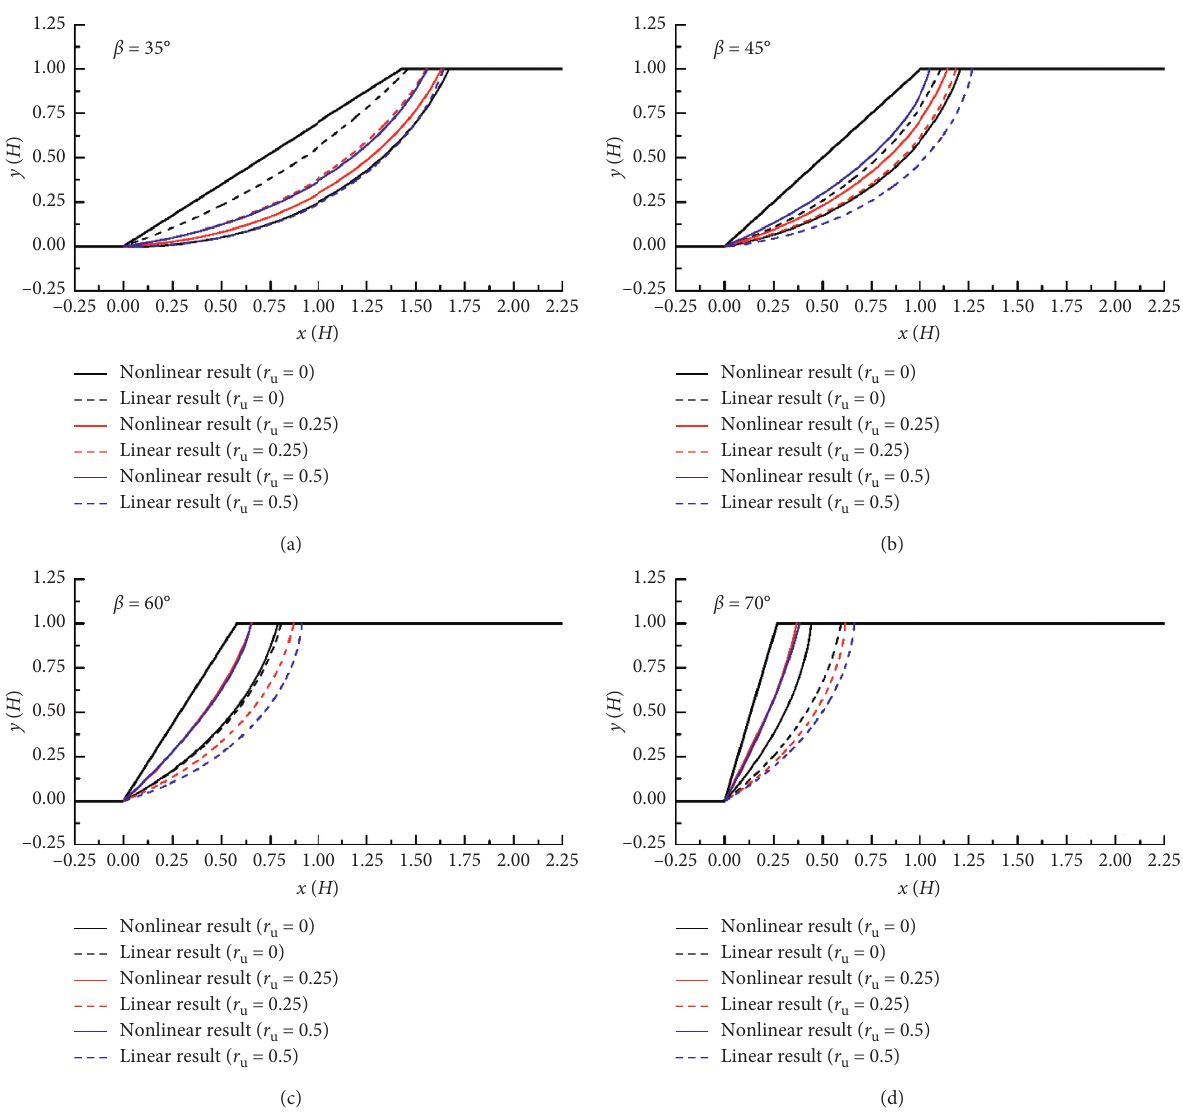
Figure 12: Critical slip surfaces of London clay slopes undergoing different pore-water pressures. (a) β � 35 ° . (b) β � 45 ° . (c) β � 60 ° . (d) β � 75 °